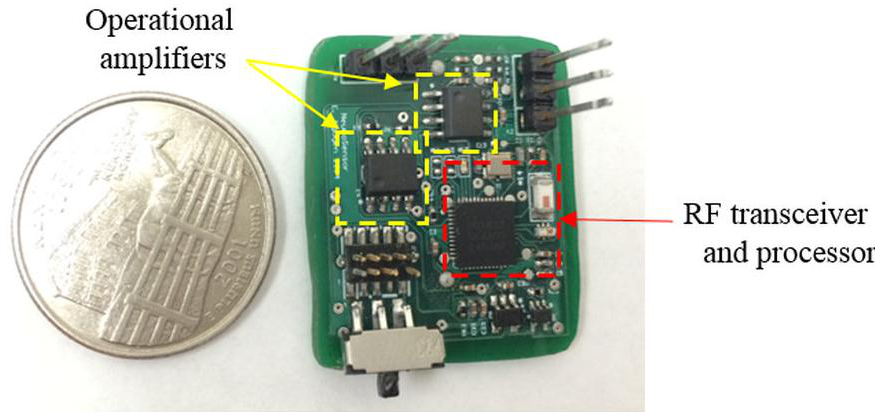
Figure 2. Photo of the neurotransmitter sensor recording device with a dimension of 25 × 27 × 6 mm 3 . The module included multi-stage amplifiers and a system-on-chip (SoC) processor with an integrated radio-frequency (RF)